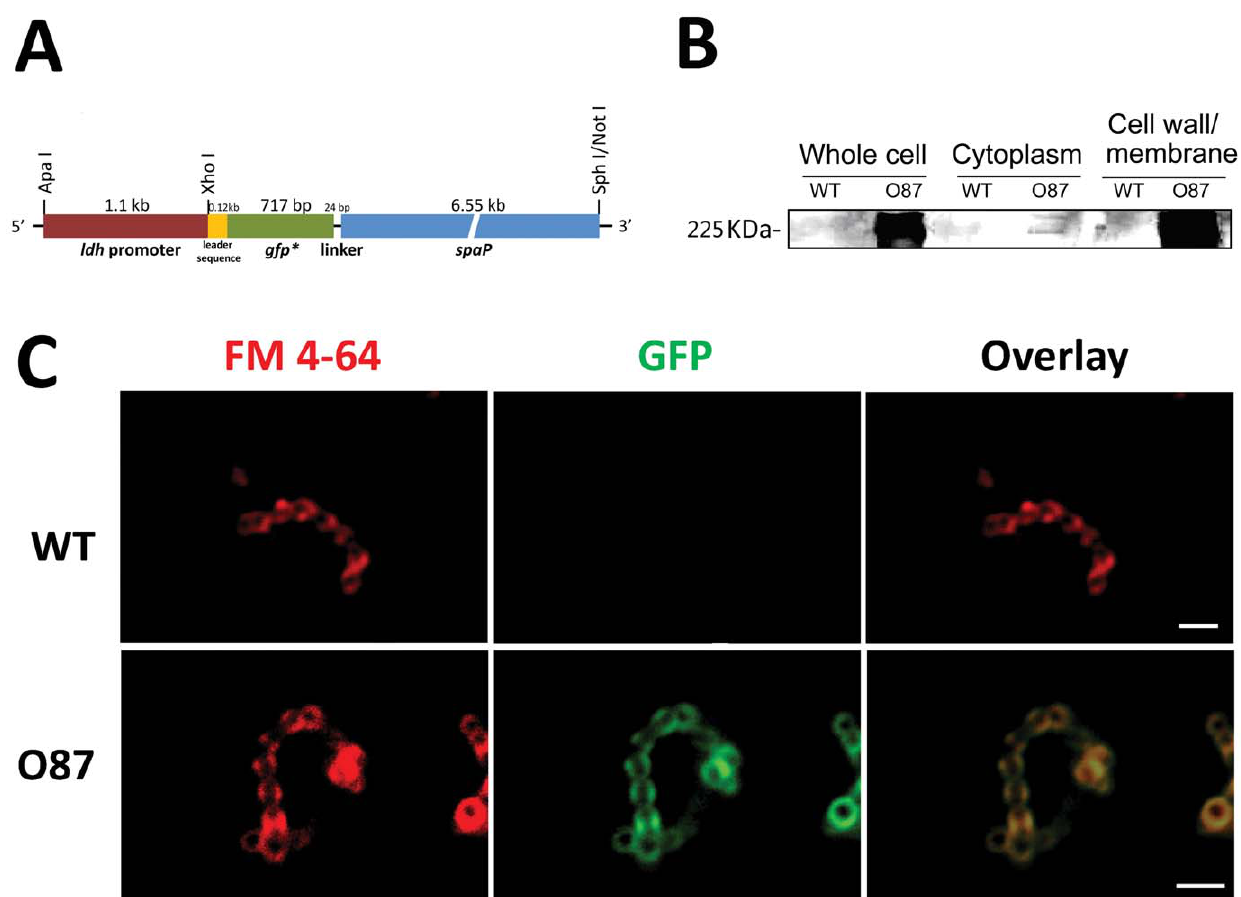
Figure 1. Construction of S.mutans O87 with cell surface-expressed pHluorin. (A) gfp -fusion construct. The illustration shows the construct for surface-displayed expressed pHluorin in S. mutans (strain O87). The ecliptic pHluorin gene was inserted between the second and third amino acids after the identified signal-peptide cleavage site of the surface protein SpaP to enable orientating the pHluorin onto the cell wall of S. mutans . (B) Western blot with a GFP antibody shows the presence of the surface-expressed chimeric pHluorin-SpaP fusion protein (225 kDa) in S. mutans strain O87. The different cell fractions are indicated above each lane. (C) CLSM analysis of pHluorin localization in S. mutans strain O87, and wild-type cells (WT) served as control. Membrane staining with the lipophilic fluorescent dye FM 4–64 is shown in red ( left ), GFP signals are shown in green ( middle ), and the overlay images on the right. The images were taken with a 63 6 objective and deconvoluted to resolve cellular localization. The scale bars represent 2 m